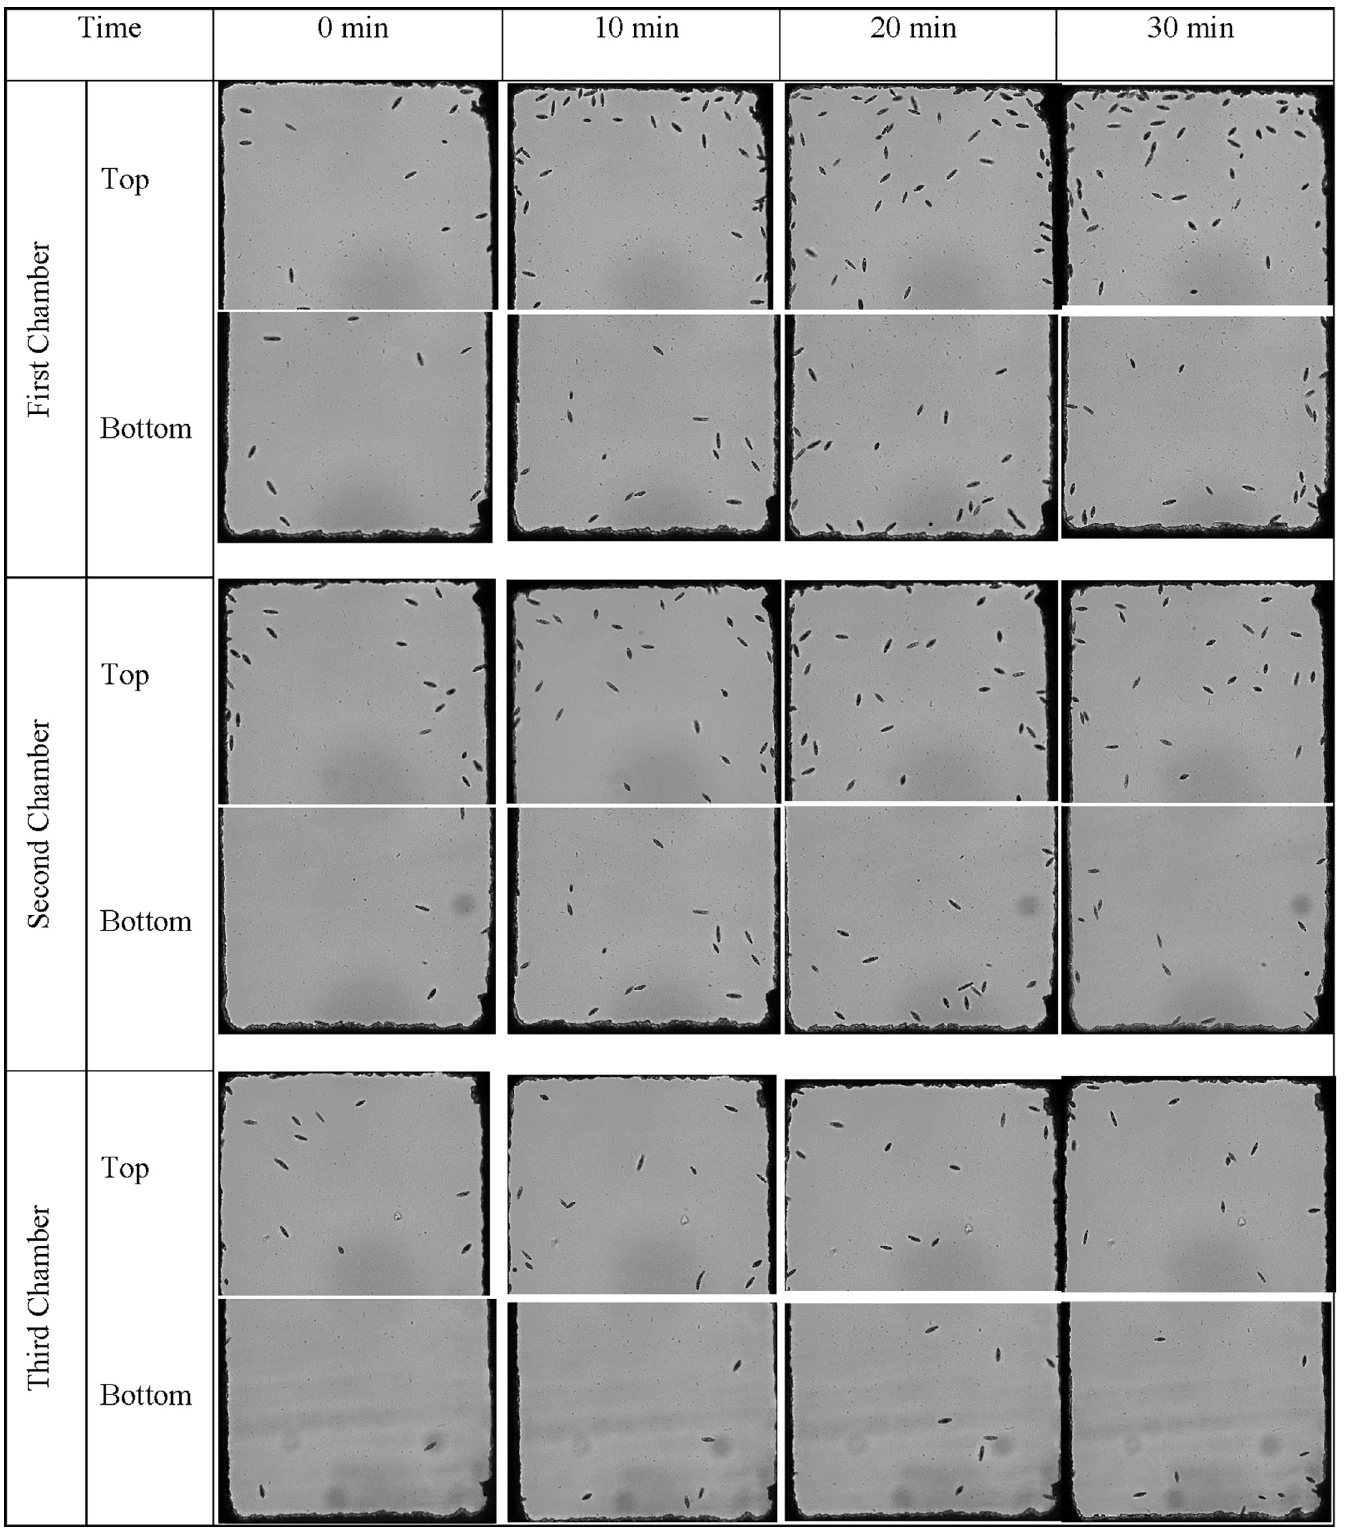
Fig 3. Euglena cell distribution inside the microfluidic device with two side channel filled with 0.1% peptone during the experimental duration. The flow rate of Euglena suspension was 3 μ L/h. Pictures were taken at the end of each set of chambers at 0 min, 10 min, 20 min, and 30 mins after the chemmoeffector (0.1% peptone) was introduced in the microfluidic system.